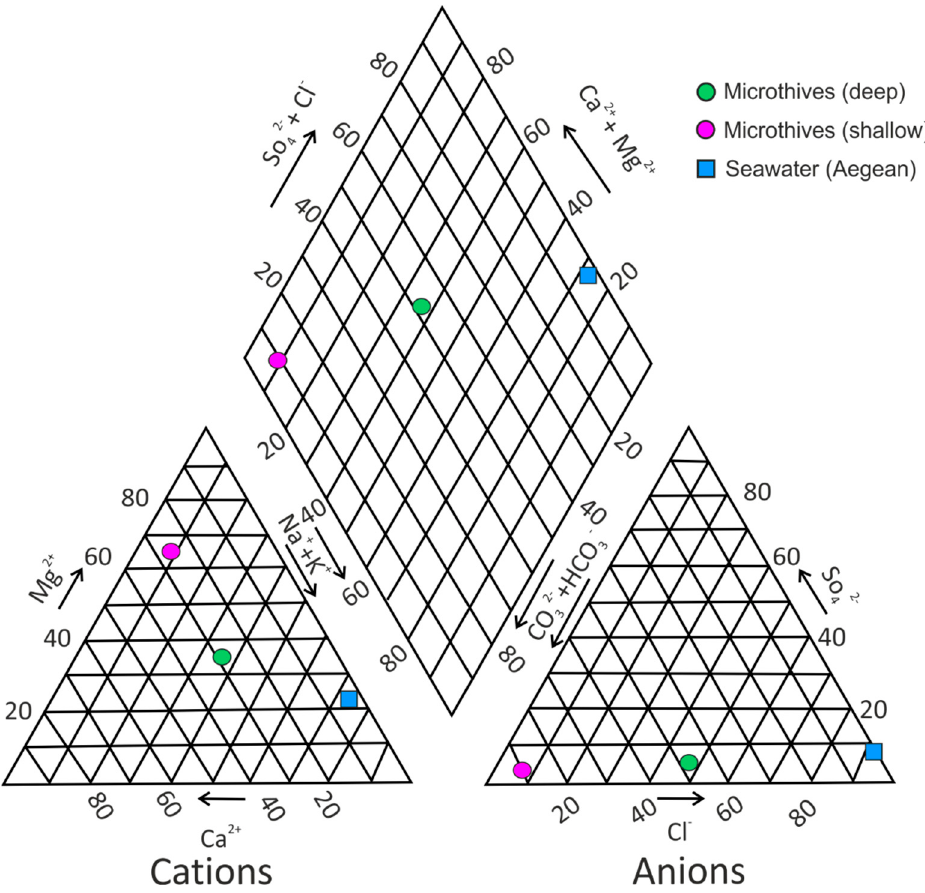
Figure 4. Piper diagram [46] for the water samples of Microthives and Aegean regions.